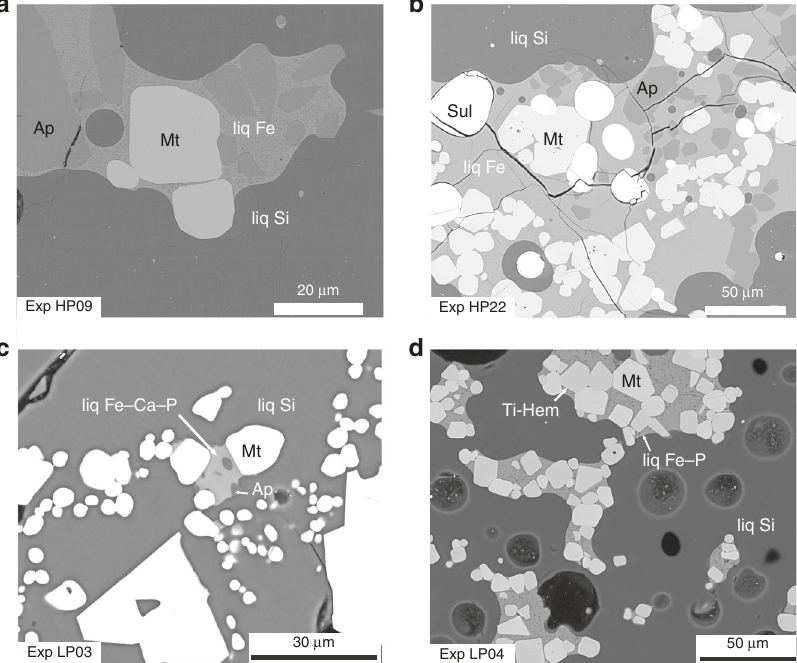
Fig. 1 Back-scattered electron images of selected experiments showing liquid immiscibility between Fe-rich and Si-rich glass. a , b Typical irregularly shaped (coalesced) patches of Fe-rich silicate glass (liq Fe) within Si-rich glass (liq Si). Magnetite and/or apatite are preferentially enclosed in the immiscible Fe- rich silicate glasses. c Fe – Ca – P glass (liq Fe – Ca – P) separated from the Si-rich glass (liq Si). Magnetite and apatite are crystalline phases in both liquids. d Irregularly shaped (coalesced) patches of Fe – P glass (liq Fe – P) within Si-rich glass. Oxide minerals (Ti-rich hematite and magnetite) are predominantly hosted by the Fe – P glass. Abbreviations: Mt, magnetite; Ti-Hem, solid solution of ilmenite and hematite; Ap, apatite; Sul, sul fi de; liq Fe, Fe-rich silicate glass; liq Fe – Ca – P, Fe – Ca – P glass; liq Fe – P, Fe – P glass; liq Si, Si-rich